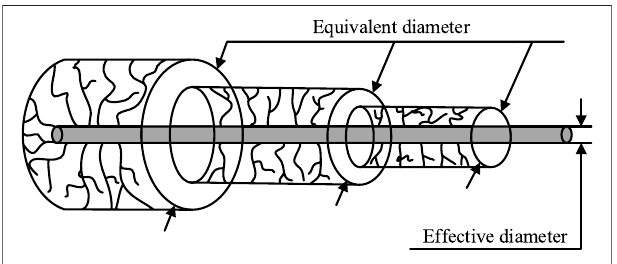
FIGURE 2 | Physical model of spark discharge fi eld of soil around grounding electrode.